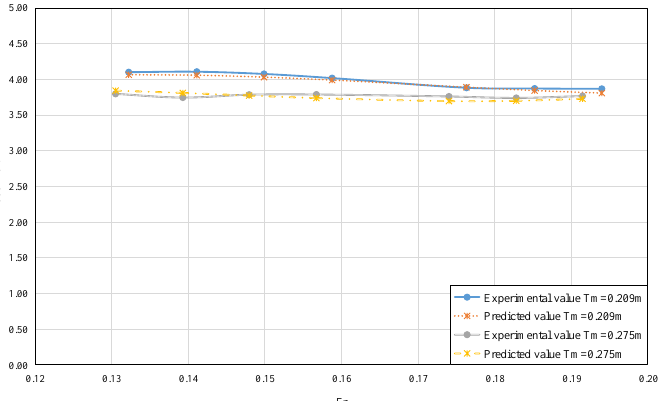
Figure 10. The curves of C t versus Fn at the drafts of 0.209 m and 0.275 m by the best performing model.